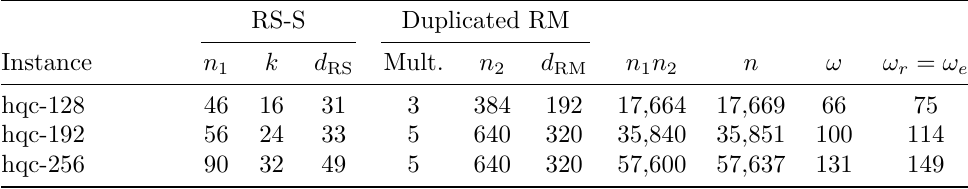
Table 1: The HQC parameter sets [AAB + 21]. The base Reed-Muller code is defined by [128 , 8 ,